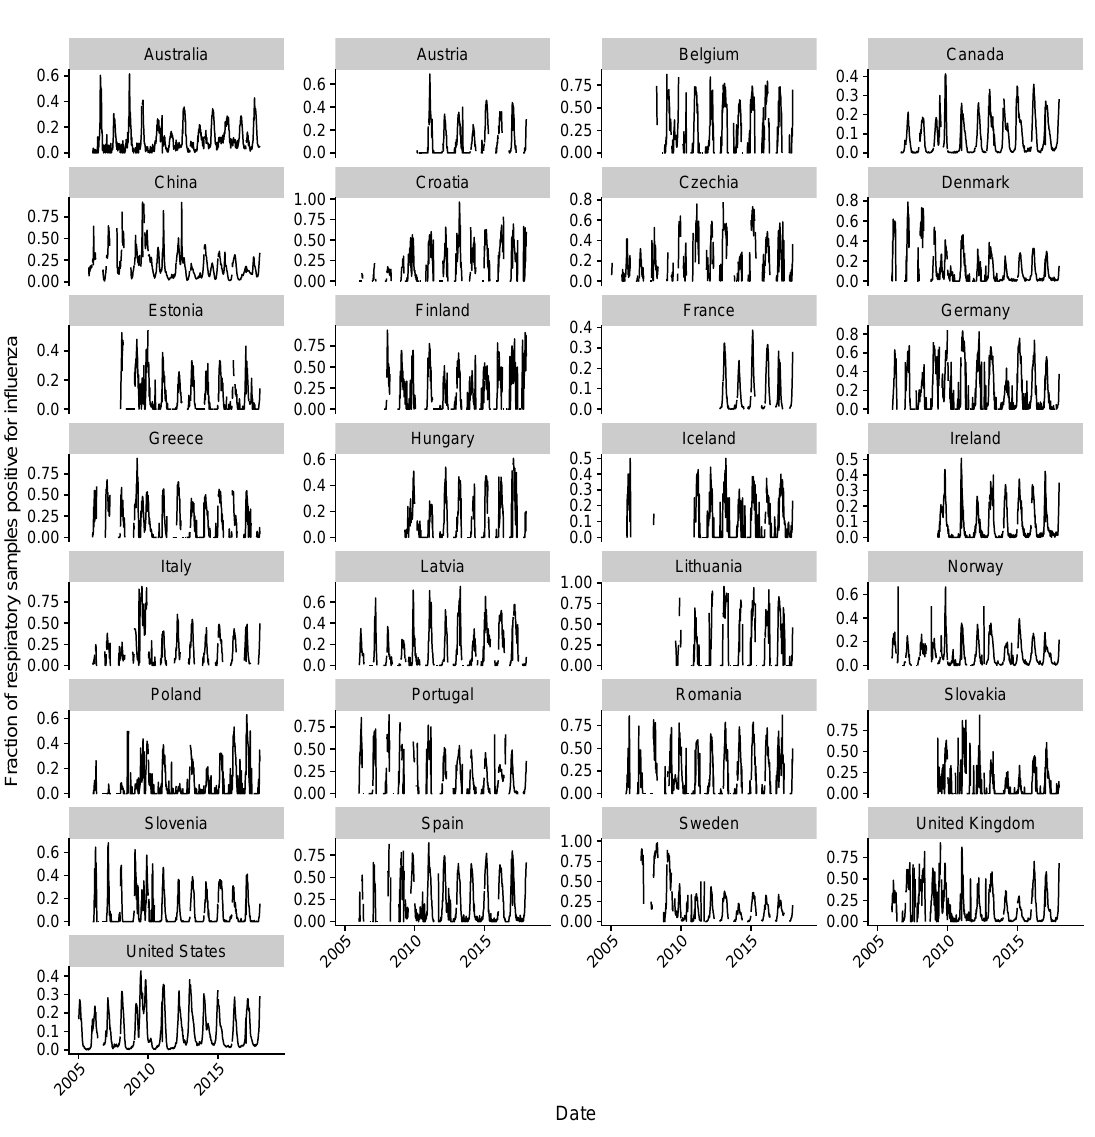
Figure A8. The fraction of laboratory tested influenza positive respiratory samples from National Influenza Centers is shown at weekly resolution, as reported in the WHO FluNet database [52]. A fixed y -axis scale is shown in Figure